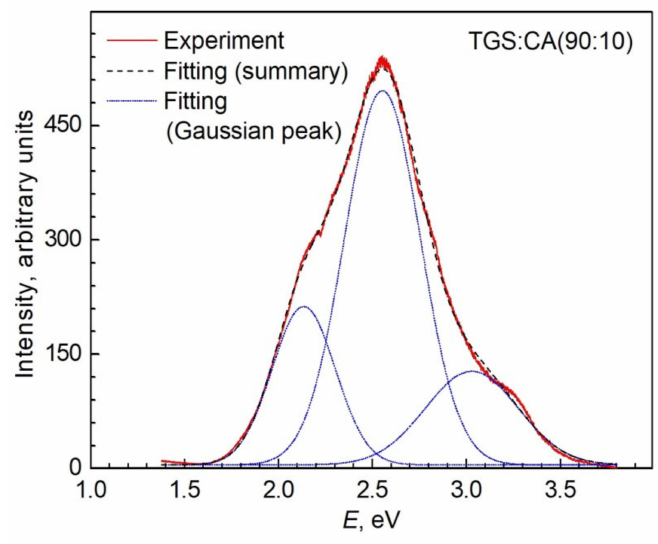
Figure 10. PL spectrum of the TGS:CA (90:10) crystal upon excitation with λ exc = 325 nm ( E exc ph = 3.81 eV). The decomposition of the PL contour into three Gaussians with maxima at E ph = 2.13 eV, 2.55 eV, and 3.03 eV is